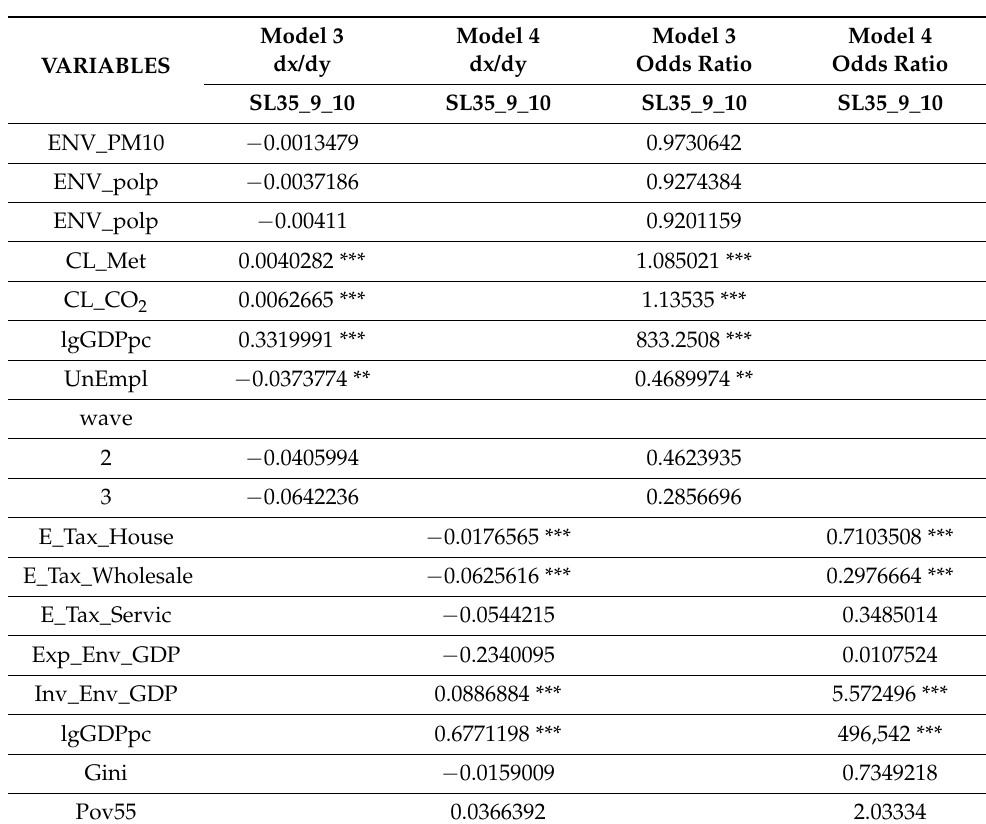
Table 2. Margins and odds